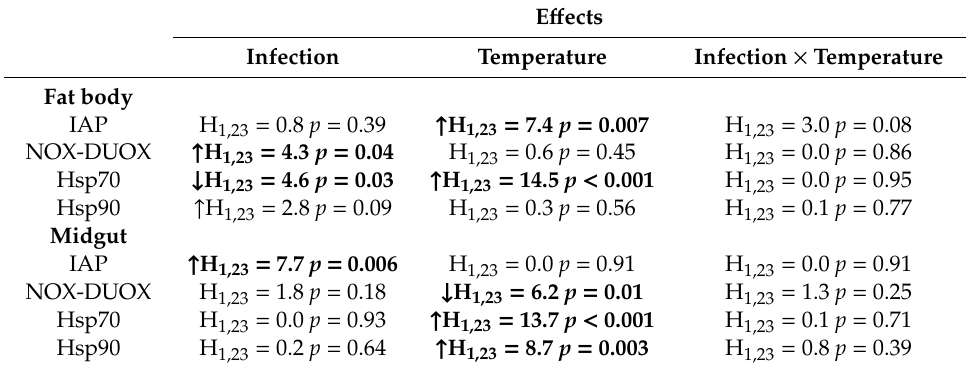
Table2. Two-waye ff ectsof C.militaris infectionandtemperatureontheexpressionofapoptosis, ROSand stress-related genes. Significant e ff ects highlighted in bold. Arrows show up- or downregulation of genes in response to infection and in response to cooling to 15 degrees. Arrows are shown only for significant ( p < 0.05) and marginal ( p = 0.05–0.10) e ff ects.